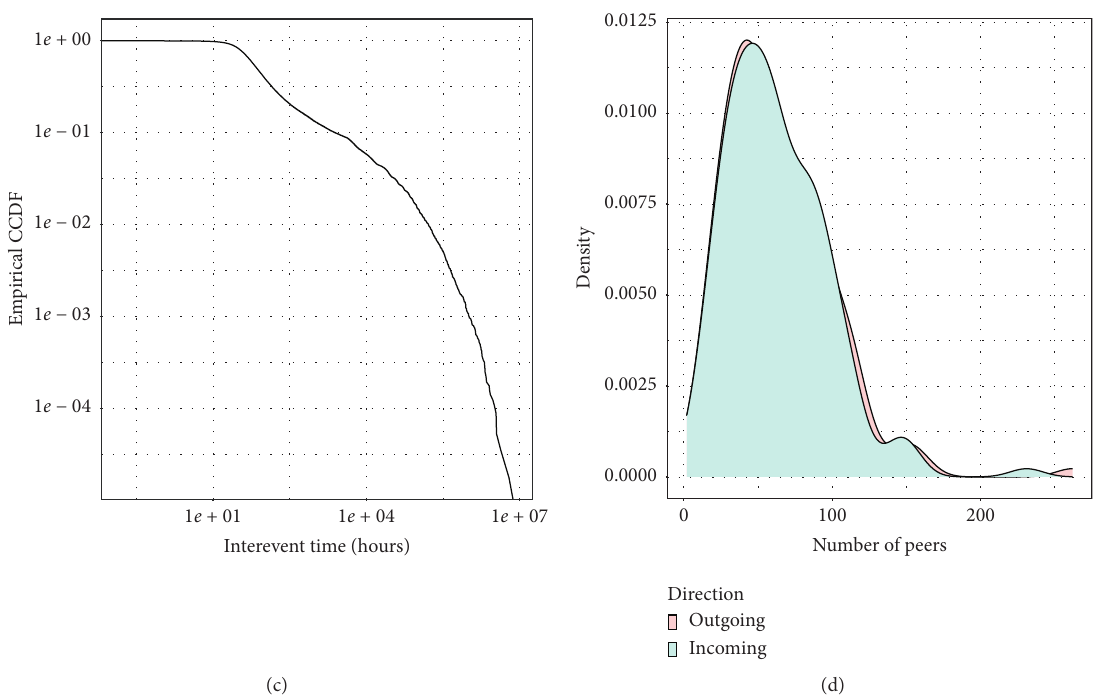
Figure 5: The exploratory analysis of the communication data for students participating in the NetSense study at the University of Notre Dame: (a) density plot for the number of communication events for the students; (b) the distribution of phone activity through the course of the day; (c) the cumulative distribution function of the interevent times in hours; (d) the number of incoming and outgoing communication peers for the students in NetSense, where there are at least twenty communication events with the peer during the analyzed period